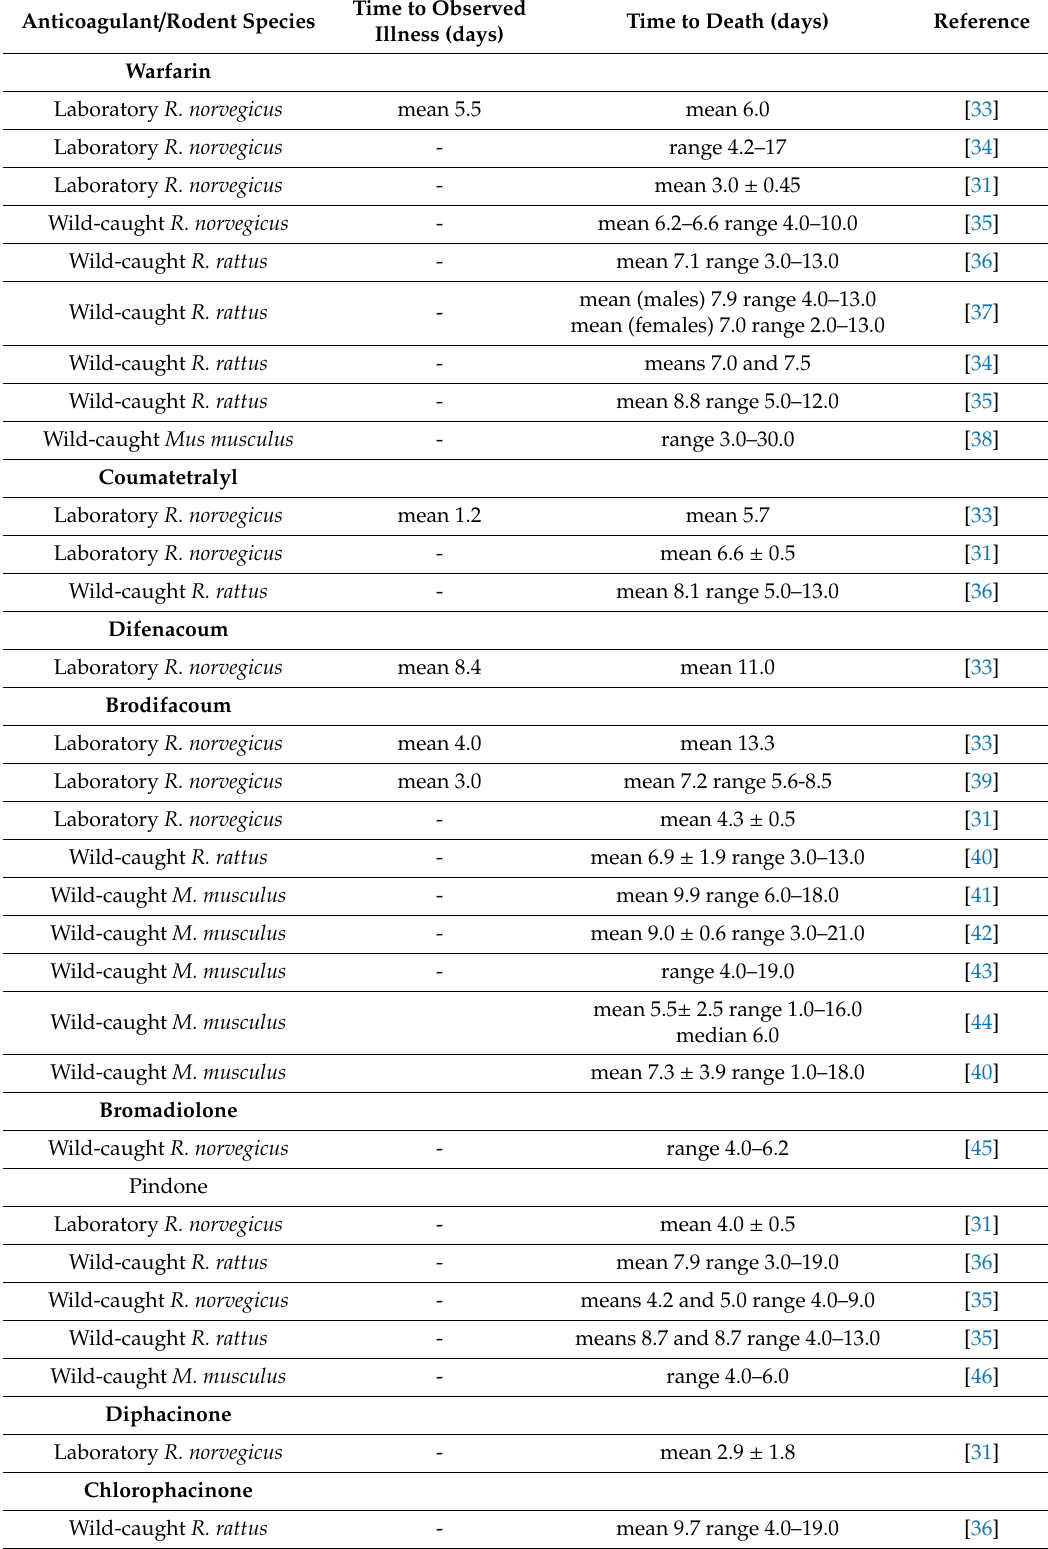
Table 1. Times to death from anticoagulant poisoning reported in studies where captive rodents voluntarily ate food (bait) containing an anticoagulant rodenticide. Anticoagulant / Rodent